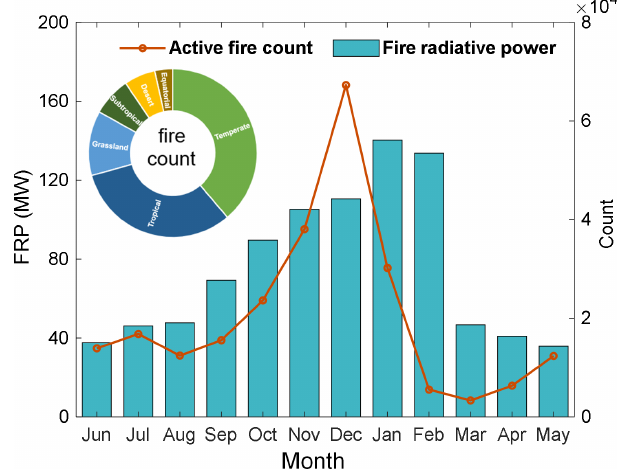
Figure 10. Monthly FRP and total active fire counts in Australia from June 2019 to May 2020. The percentages of active fire detec- tions in different climate zones of Australia from June 2019 to May 2020 are also shown in upper-left